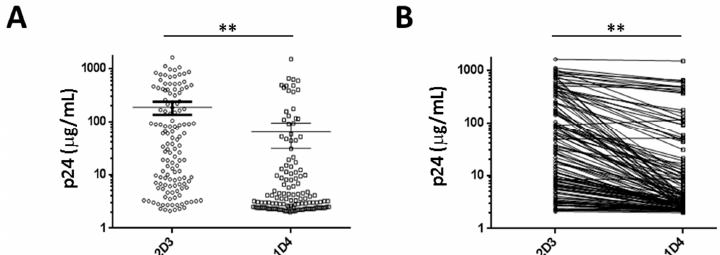
Figure 2. The p24 capsid domain (p24CA) levels in the supernatant collected from SupT1 cells harbouring Ank GAG 1D4 and Ank A3 2D3 after infection with 131 Gag/PR chimeric viruses. ( A ) Distribution of p24CA showed that the mean ± SEM of SupT1/Ank A3 2D3 and SupT1/Ank GAG 1D4 was 186.5 ± 25.8 µg/mL and 62.2 ± 16.0 µg/mL, respectively. ( B ) Significant reduction of p24CA in SupT1/Ank GAG 1D4 compared with SupT1/Ank A3 2D3 by individual samples. ** p < 0.01 was determined using a two-tailed paired Student t -test. The percentage of samples that experience reduction was 98.47%. Viruses 2018 , 10 , x FOR PEER REVIEW